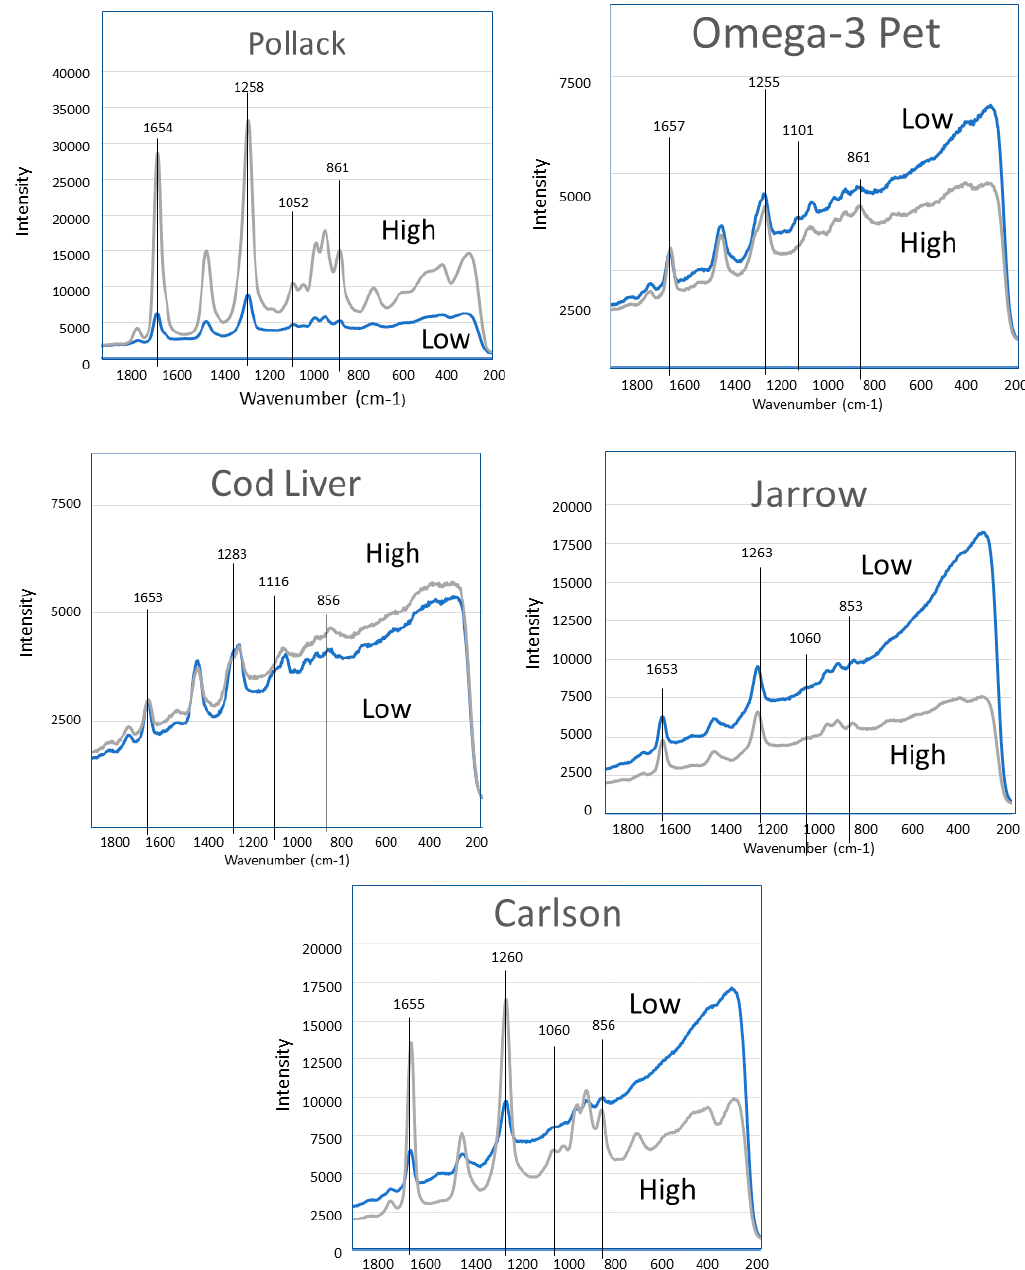
Figure 4. Representative raw line spectra for each sample when all liquid (18 °C; high) and all solid ( − 70 °C; low).